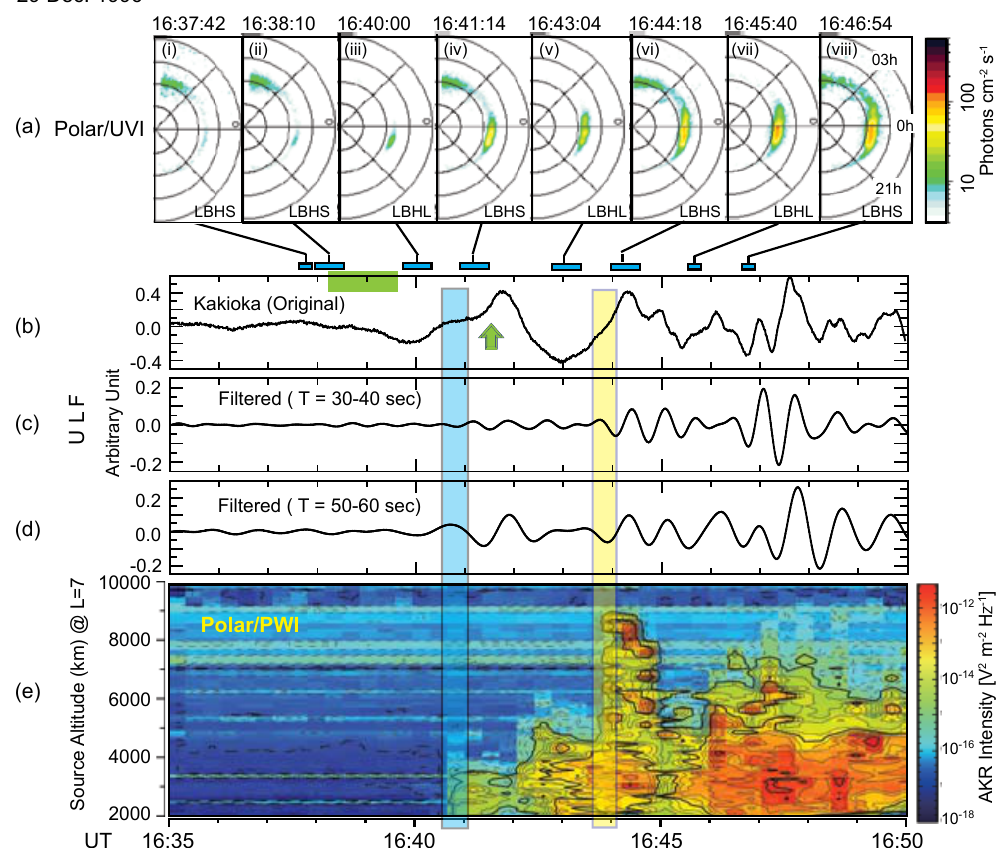
Fig. 4. Relationship between global auroral activity, AKR development, and low-latitude Pi2 pulsation on 29 December 1996. (a) Polar/UVI Fig. 4 images in dark hemisphere showing initial brightening around 16:38 (image (ii)) and breakup/poleward-expansion around 16:44UT (im- age (vi)).Small horizontal rectangles under images indicate exposure times. Green rectangle indicates “sudden brightening” defined by Liou et al. (2000). (b) dH/dt record from Kakioka; green arrow shows onset of Pi2 pulsation defined by Liou et al. (2000). (c) and (d) Filtered components ( T =30–40 and 50–60s) of dH/dt data at Kakioka. (e) a − t diagram of AKR from Polar/PWI. Low-altitude AKR appeared around 16:41UT (blue vertical rectangle), and high-altitude AKR appeared around 16:44UT (beige vertical